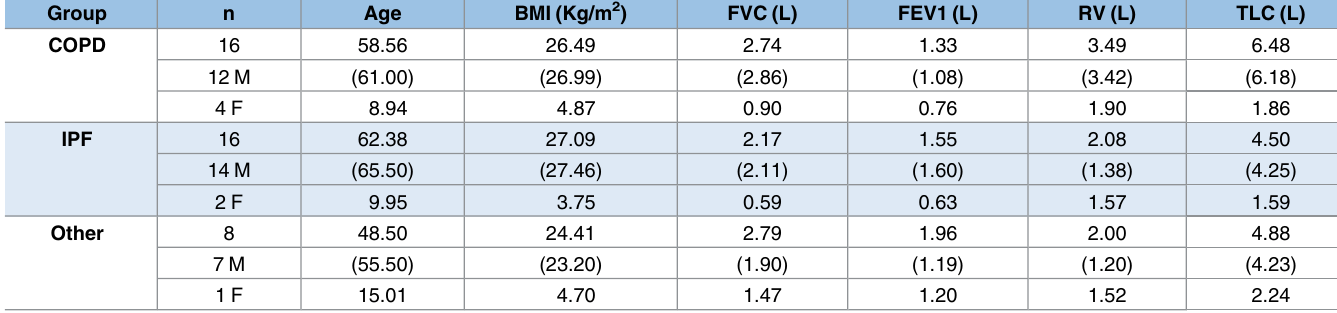
Table 1. Patient demographics. Mean (median)and standarddeviationvalues are